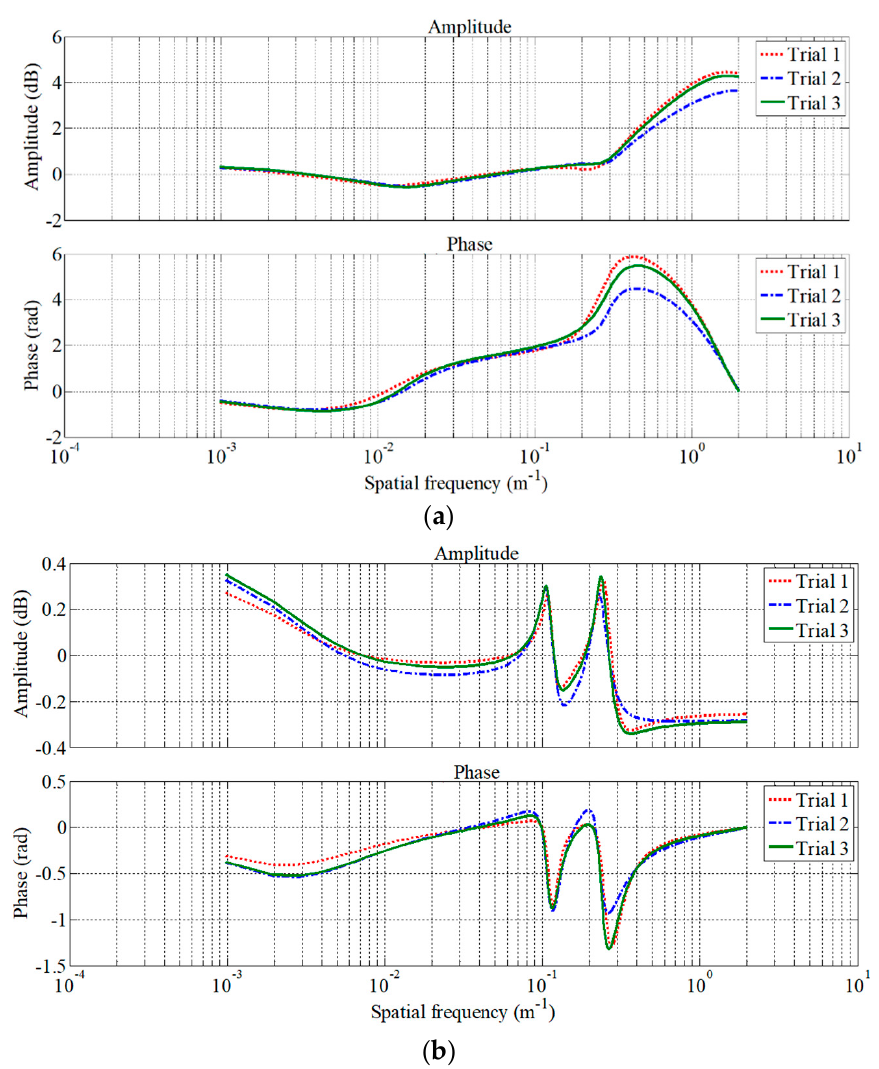
Figure 7. Frequency response of the derived models: ( a ) lateral direction; ( b ) vertical direction.